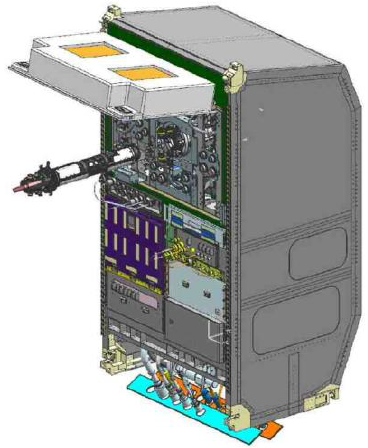
Figure 17. International Space Station electrostatic levitation furnace (ISS-ELF) main-body and sample cartridge.